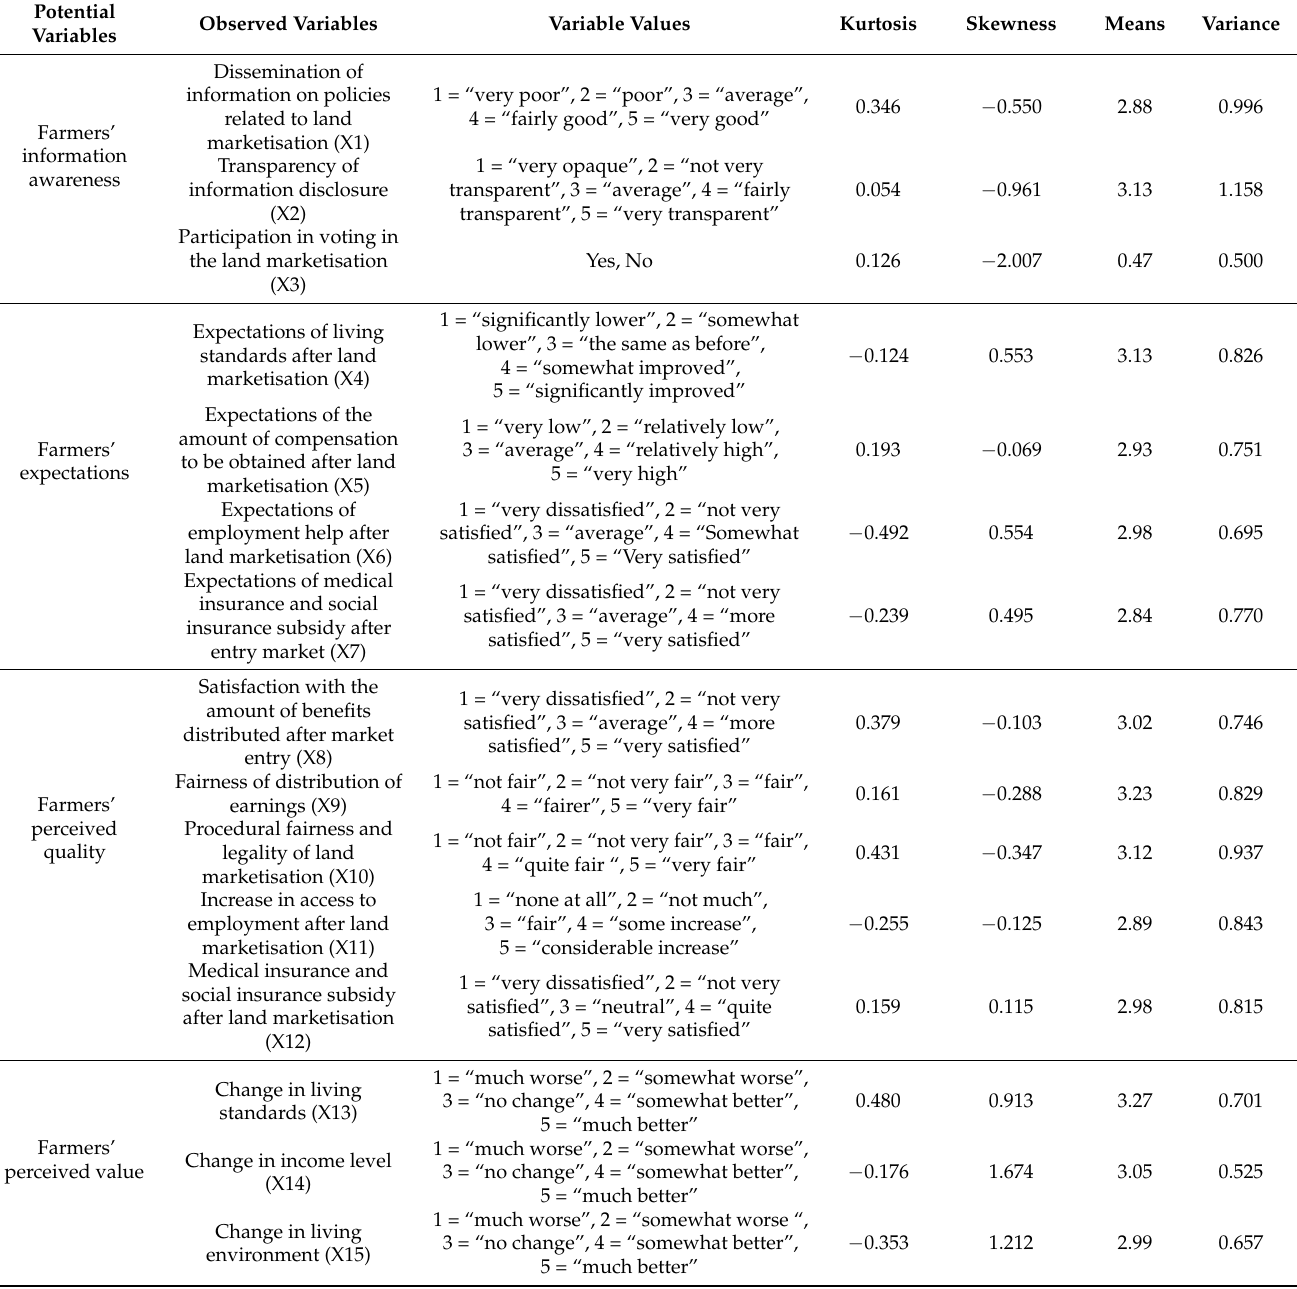
Table 1. Description of the model